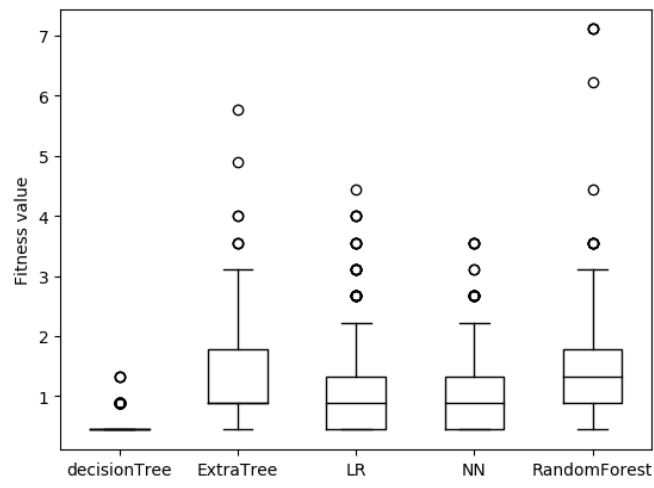
Figure 5. The fitness function values of adversarial samples for five detection models with S1 permission features.